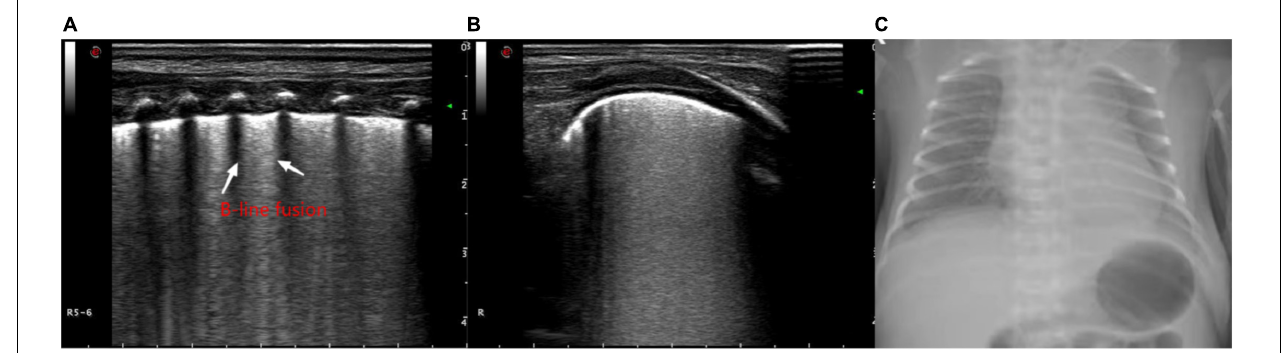
FIGURE 2 | The ultrasonographic manifestations in the lungs of a newborn with alveolar-interstitial syndrome, showing the increase of B lines and the fusion into “white lung” like changes. (A) Longitudinal image of the intercostals. (B) Transverse image along the intercostals. (C) X-ray manifestation of the decrease of light transmission in both